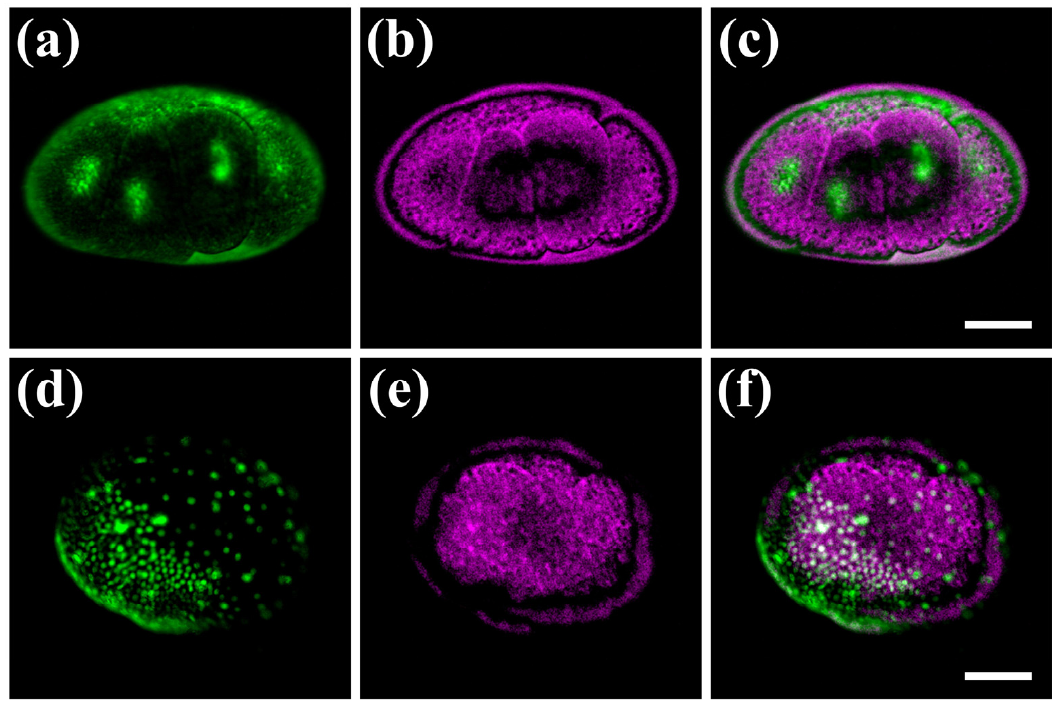
Figure 4. Hybrid imaging of fluorescently labelled Parhyale embryos. ( a – c ) Embryo at the cleavage stage S5. ( d – f ) Embryo at mid-germband stage S14. Left panels ( a , d ) show the nuclear fluorescent signal in green, middle panels ( b , e ) show the PA signal in magenta, and right panels ( c , f ) show the merged images. In panels ( d , f ), the densely packed nuclei in the anterior-ventral region and the scattered nuclei in the posterior-dorsal region correspond to the embryonic and extra-embryonic parts of the embryo, respectively. Scale bars are 100 μ m.